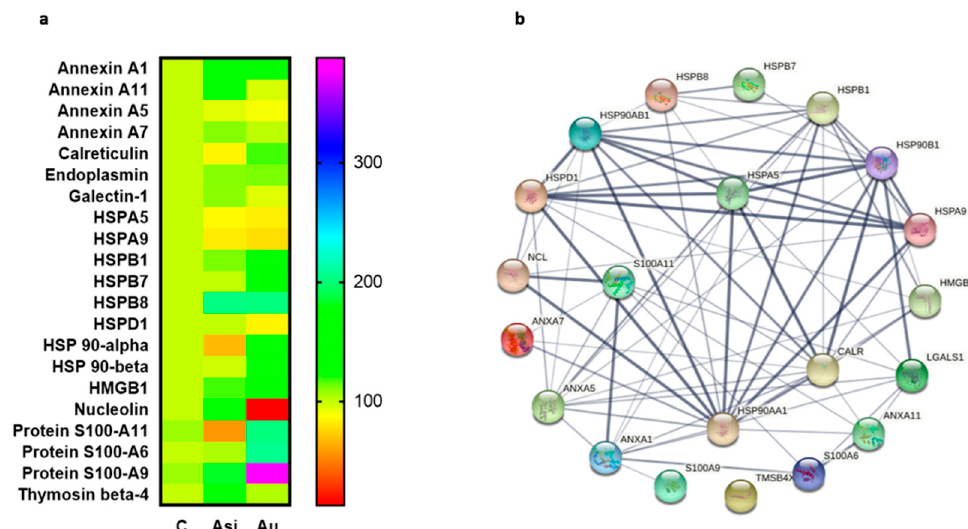
Figure 6. Quantitative and interaction-based profiles of identified alarmins. Heat map representation of identified alarmins ( a ) and the protein–protein interaction network and ( b ) using STRING analysis of the molecules (Heat shock proteins A5, A9, B1, B7, B8, 90AA1, 90B1, D1, nucleolin, annexin A7, thymosin β 4, S100 A6, A9, and A11 proteins). The heatmap legend shows the normalized scaled-down levels of spectral abundance, while the nodes in the right network are connected using protein–protein associations or edges with confidence levels between 0.150 (low) and 0.900 (highest). All nodes are colored and signify query proteins and the first shell of interactors.